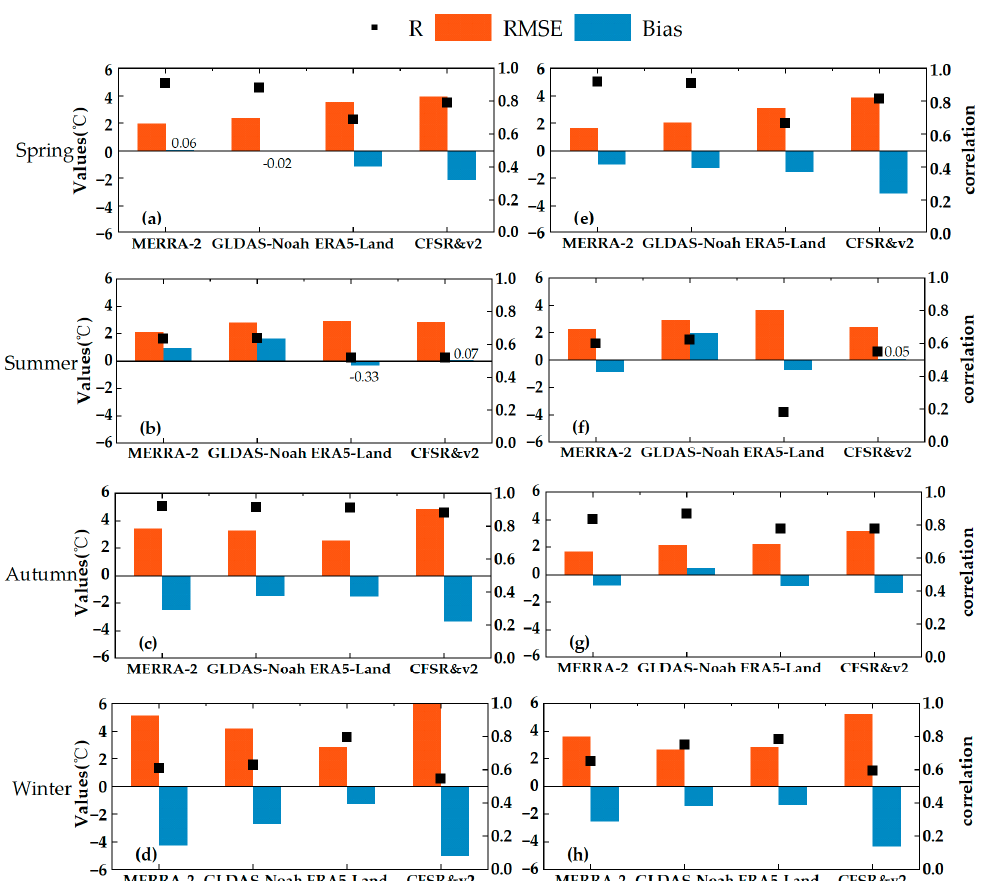
Figure 4. R, RMSE, and bias of the reanalyzed datasets and calibrated soil temperature in different seasons. (Spring: March–May, summer: June–August, autumn: September–November, and winter: December–February). ( a – d ) 10 cm, ( e – h ) 50 cm. The left y-axis represents the error values, and the right y-axis represents the correlation coefficient values.